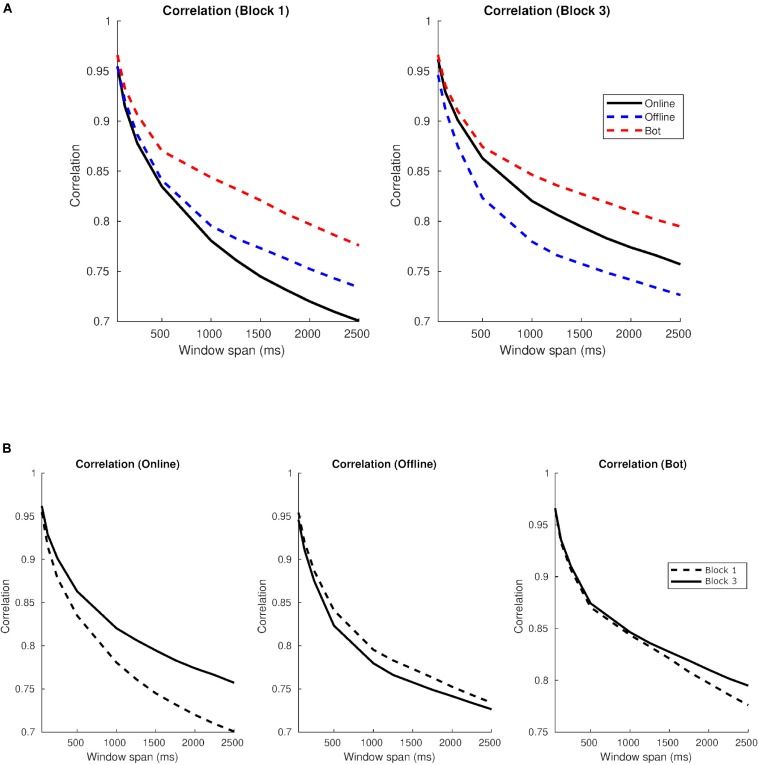
Correlations in auditory blocks and per type of agent in Study 1. (A) Correlation indices in block 1 (left) and block 3 (right) per type of agent as a function of the window span. (B) Correlation indices per online agent (left), offline agent (medium) and oscillatory bot (right) in block 1 and block 3.